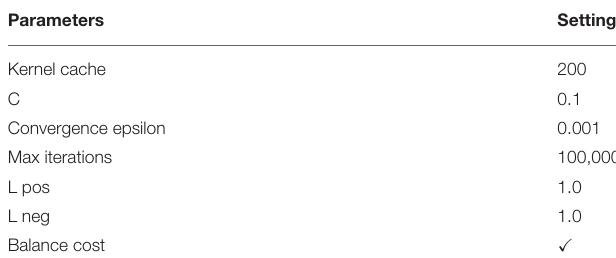
TABLE 2 | The parameters setting of the LSVM method.